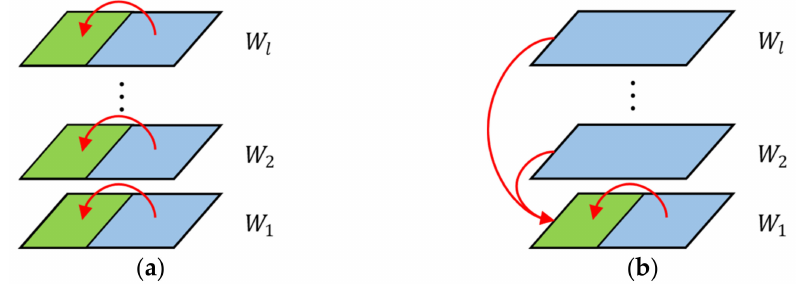
Figure 3. Comparison of two retraining approaches. ( a ) Horizontal retraining in INQ. ( b ) Global retraining in GSNQ. W l denotes the weight set of layer l , the green parts denote the quantized low-precision weight sets, the blue parts denote the full-precision weight sets used for retraining, and the arrows denote the loss-compensation